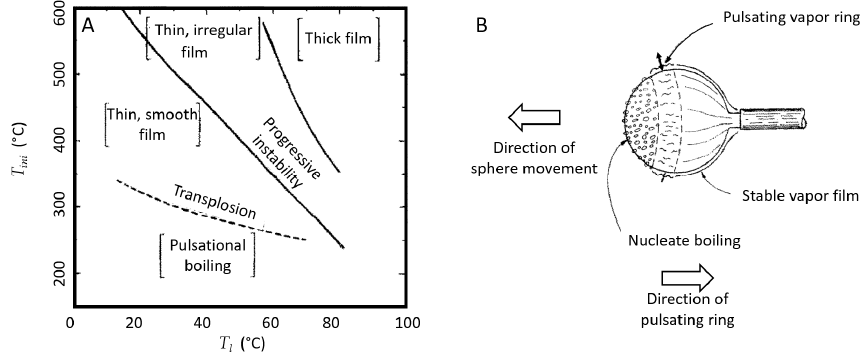
Figure 12. Additional findings of Stevens and Witte (adapted from Reference [66]): ( A ) Characteri- zation of vapor film (and its destabilization, i.e., step 1) as a function of coolant temperature ( T l , X-axis) and initial sphere temperature ( T ini , Y-axis); ( B ) graphic representation of 3-region boiling (i.e., step 3).